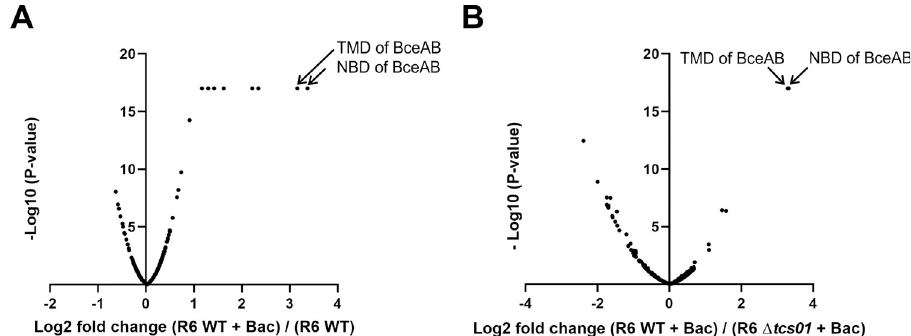
Fig 5. Proteomic analysis of wild-type and Δ tcs01 R6 strains with or without bacitracin treatment. Data correspond to one biological replicate (experiment 2, see Material and Methods), while data from another biological replicate (experiment 1, see Material and Methods) are shown in S5 Fig. (A) volcano plot showing proteins differentially expressed in the wild-type strain upon bacitracin (Bac) treatment (1 μ g/ml for 45 min). (B) volcano plot showing proteins differentially expressed in wild-type strain as compared to the Δ tcs01 in the presence of bacitracin. Proteins are significantly overrepresented when Log2 (fold change) > 1 and–Log10 (P-value) > 1.3. Proteins are significantly underrepresented when Log2 (fold change) < -1 and–Log10 (P-value) > 1.3.